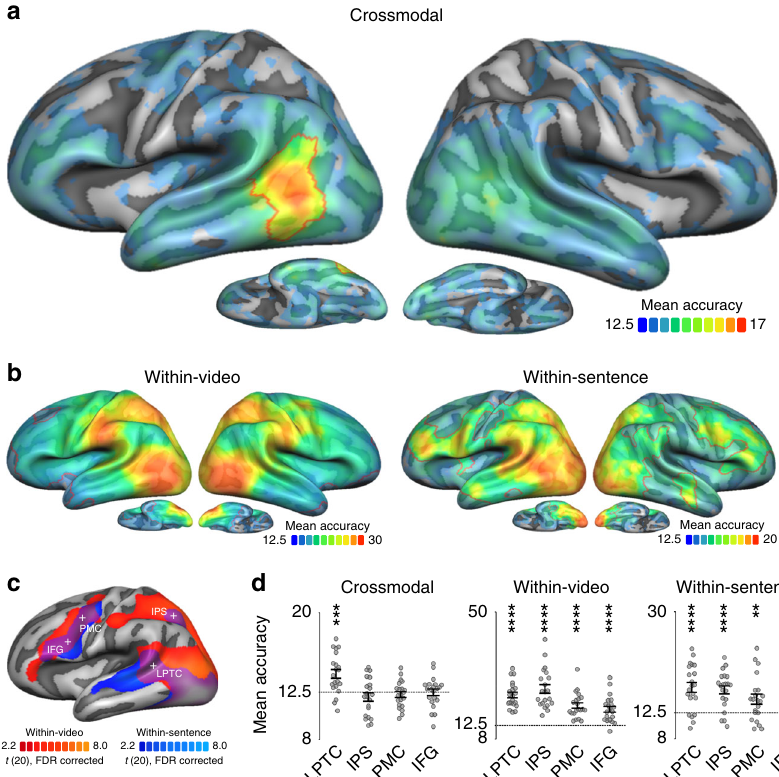
Fig. 2 Multiclass action decoding searchlight (mean accuracies, chance = 12.50%). Mean accuracy maps of crossmodal ( a ) and within-modality ( b ) classi fi cations. Red outlines indicate TFCE-corrected areas; uncorrected areas are displayed to indicate putative trends for above chance decoding in areas not surviving correction (for clarity, higher transparency is applied to uncorrected areas). c Overlap of univariate activation maps for the contrasts action videos vs. baseline and action sentences vs. baseline (FDR-corrected). Spherical ROIs (12 mm radius) were centered on conjunction peaks (indicated by crosses). d ROI decoding accuracies for crossmodal and within-modality classi fi cation. Asterisks indicate FDR-corrected effects: ** p < 0.01, *** p < 0.001, **** p < 0.0001. Error bars/lines indicate SEM. IFG inferior frontal gyrus, IPS intraparietal sulcus, LPTC lateral posterior temporal cortex, PMC